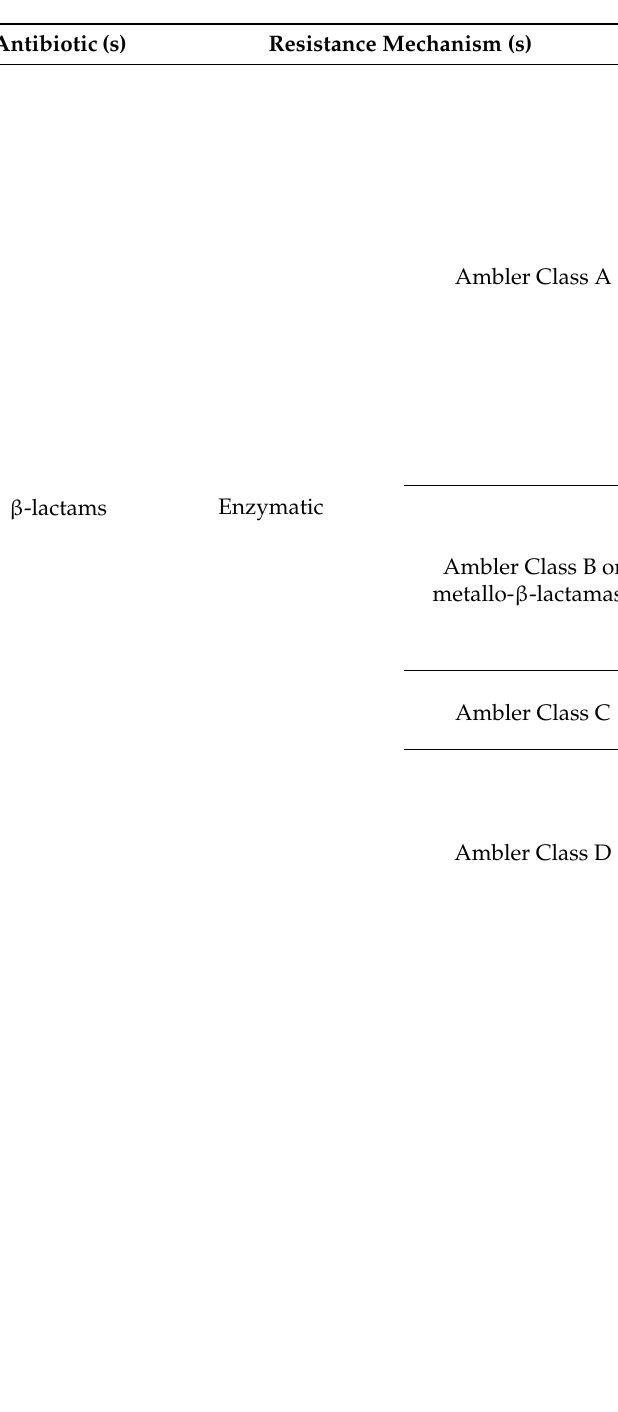
Table 1. Antibiotic resistance mechanisms associated with A. baumannii (adapted from Lee et al.